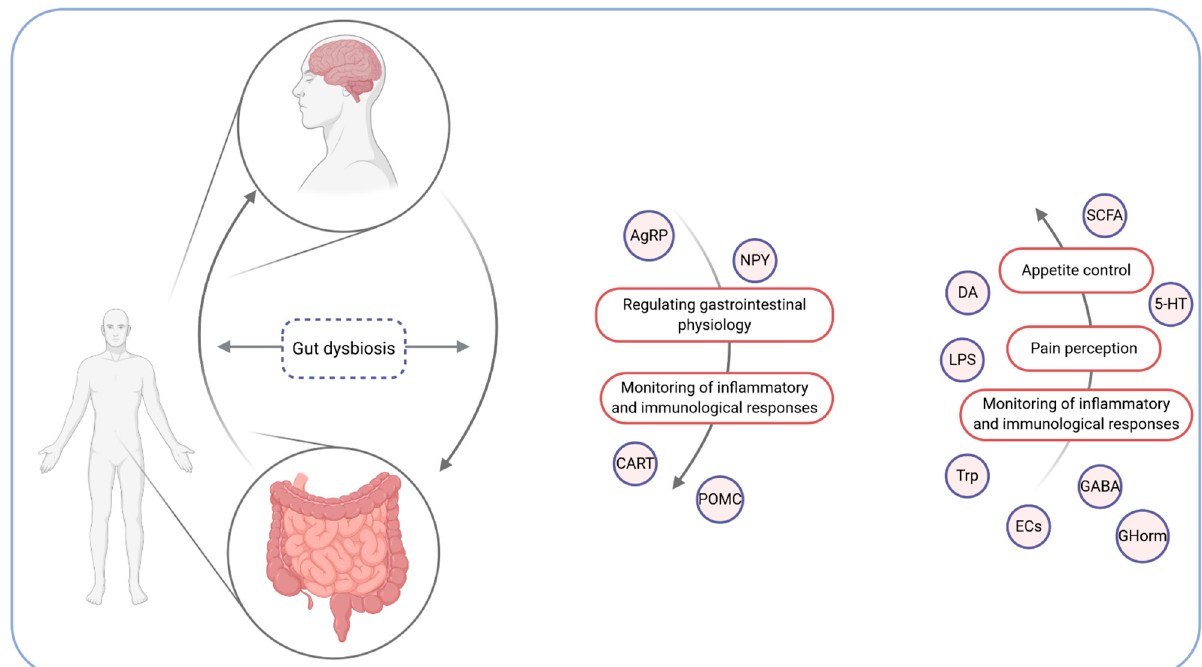
Figure 1. The brain–gut axis. AgRP—agouti-related protein; CART—cocaine- and amphetamine-regulated transcript; POMC—pro-opiomelanocortin; NPY—neuropeptide Y; GHorms—gastrointestinal hormones (e.g., cholecystokinin, lep- tin, glucagon-like peptide 1); DA—dopamine; SCFAs—short-chain fatty acids; 5-HT—5-hydroxytryptamine; LPS—lipo- polysaccharide; Trp—tryptophan; ECs—endocannabinoid ligands; GABA—gamma-aminobutyric acid.